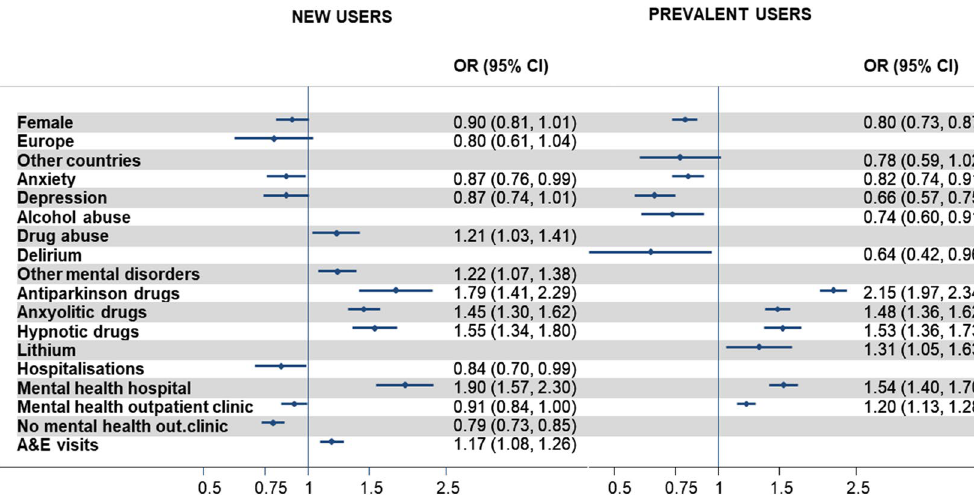
Figure 2. Factors associated with antipsychotic polypharmacy. Both models were adjusted for all variables included in Table 1 using backward-stepwise logistic regressions (with a removing probability of 0.10 and an entry probability of 0.05) to retain the significant variables. Covariates are not presented or cells are left empty in case of non-significance in the particular model. OR Odds Ratio, out . outpatient, A&E Accident and Emergencies, CI Confidence